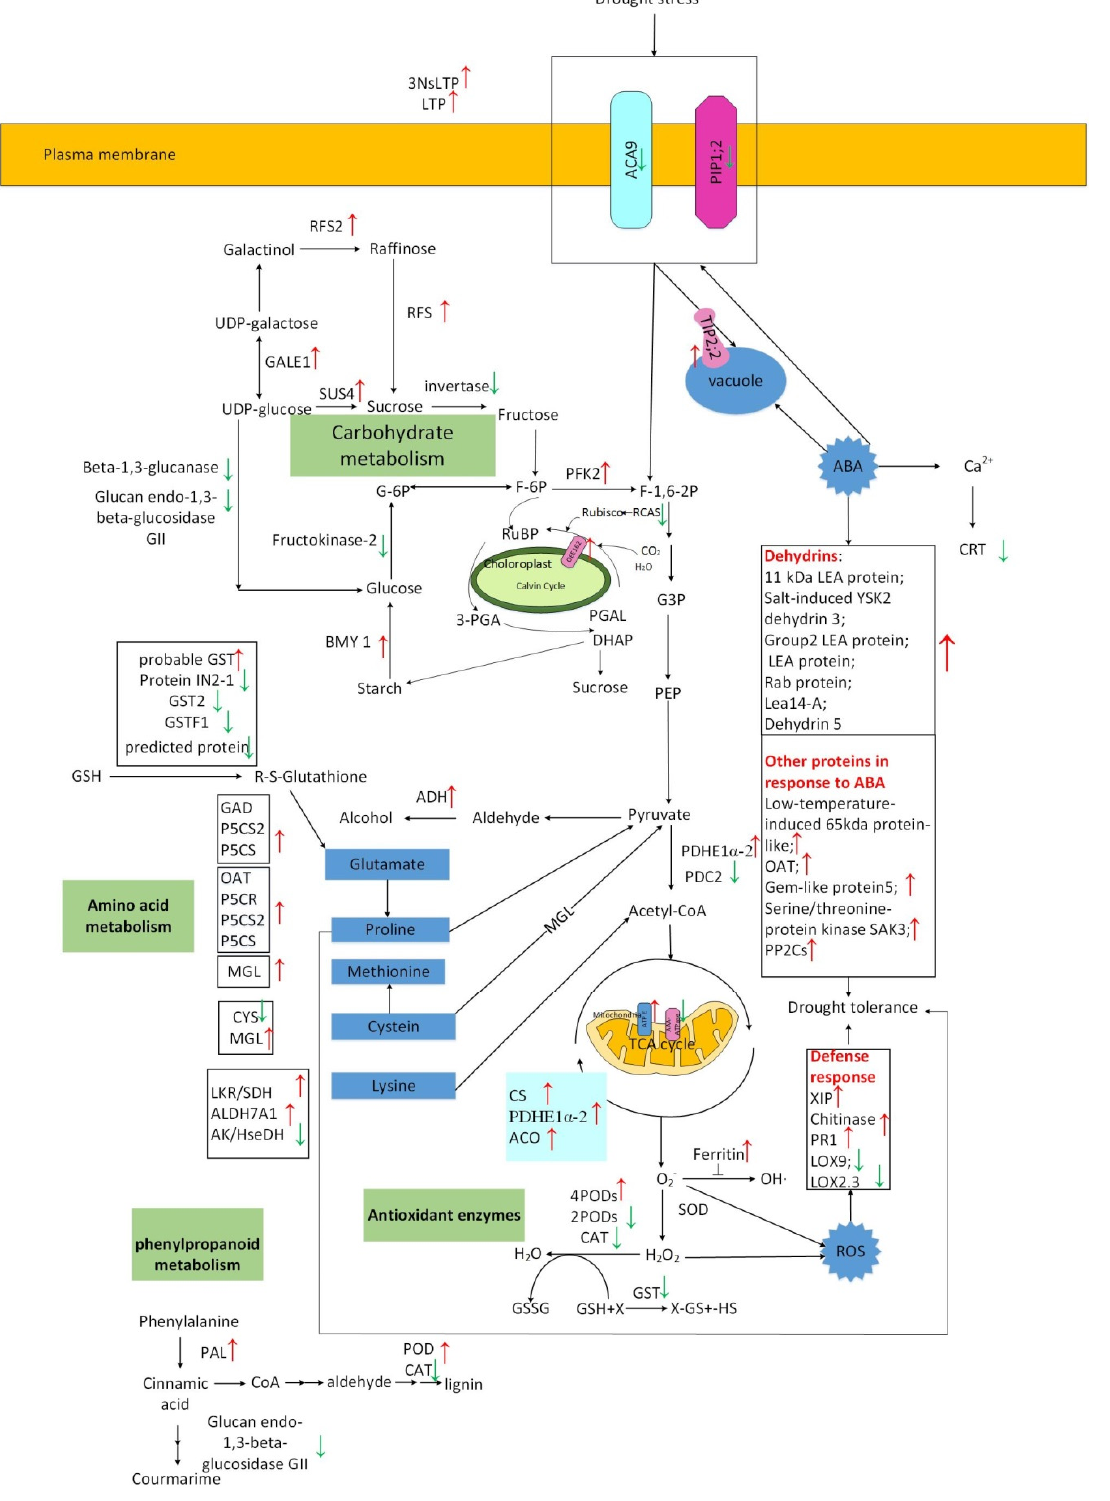
Figure 9. A pathway model of drought stress responses in Jinmai 47 seedlings. Abbreviations: NsLTP: non-specific lipid-transfer protein; LTP: lipid transfer protein; ACA9: probable calcium-transporting ATPase 9; GALE1: UDP-glucose 4-epimerase 1; RFS: probable galactinol-sucrose galactosyltransferase; PIP2-5: aquaporin PIP2-5; TIP2;2: probable aquaporin TIP2-2; SUS4: sucrose synthase 4; Invertase: cell wall invertase; PFK2: ATP-dependent 6-phosphofructokinase 2; PDHE1 α -2: pyruvate